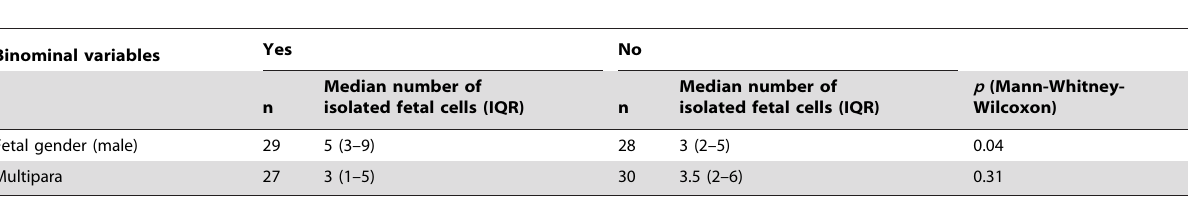
Table 2. The number of isolated fetal cells in 30 ml maternal blood in relation to fetal gender and multipara.